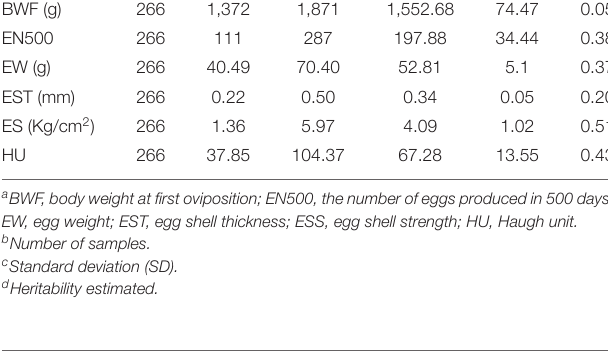
TABLE 2 | Trait correlation